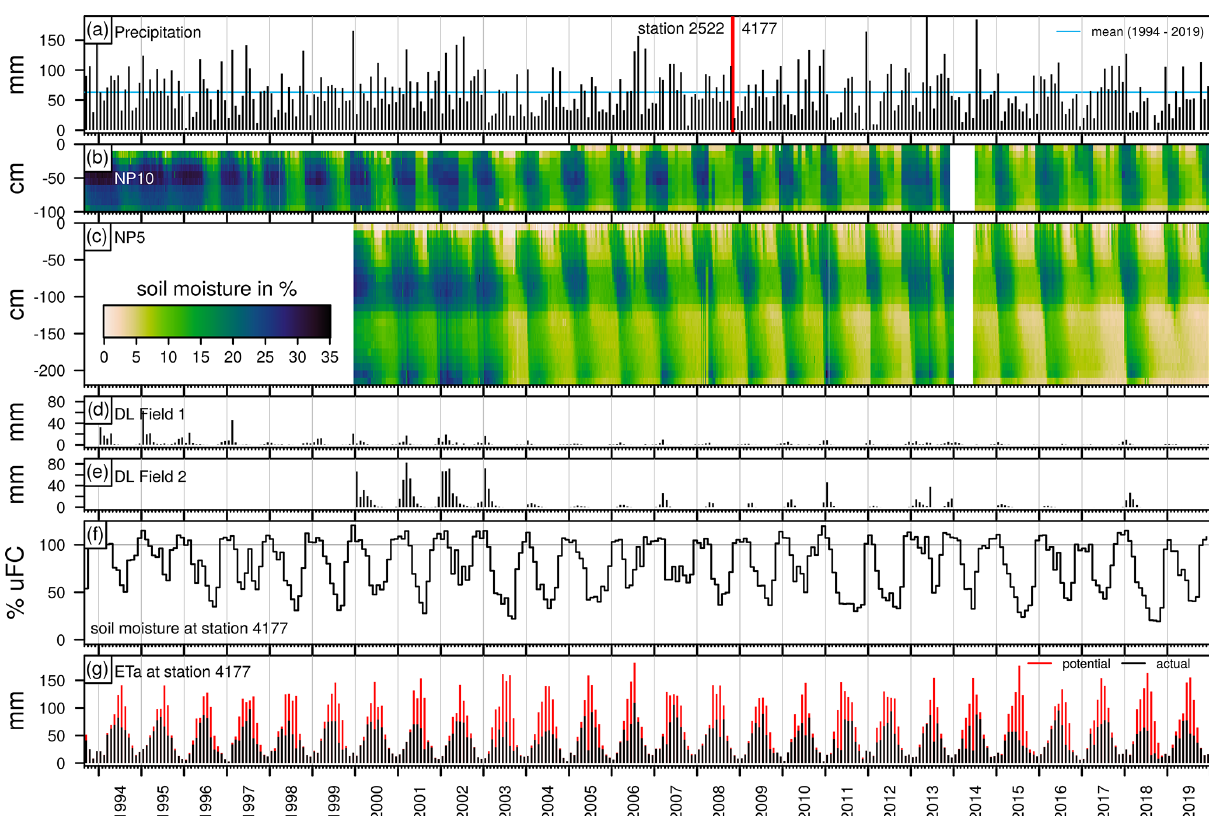
Figure 6. (a) Monthly precipitation at stations 2522 (January 1994–October 2008) and 4177 (November 2008–December 2019) (DWD Climate Data Center (CDC), 2020). Blue line represents mean monthly precipitation during 1994 to 2019. (b, c) Time series of selected soil moisture measurements (NP5 and NP10, respectively) at the test site near Karlsruhe, Germany. (d, e) Monthly discharge of the drainage layer (DL) at both lysimeters. (f) Simulated monthly averages of usable field capacity (loamy sand). (g) Monthly values of simulated potential evapotranspiration (red) and simulated actual evapotranspiration (black) (DWD Climate Data Center, 2020) at station 4177. Measurements on Field 2 are available from 2000 onward. No measurements were taken during the first half of the year